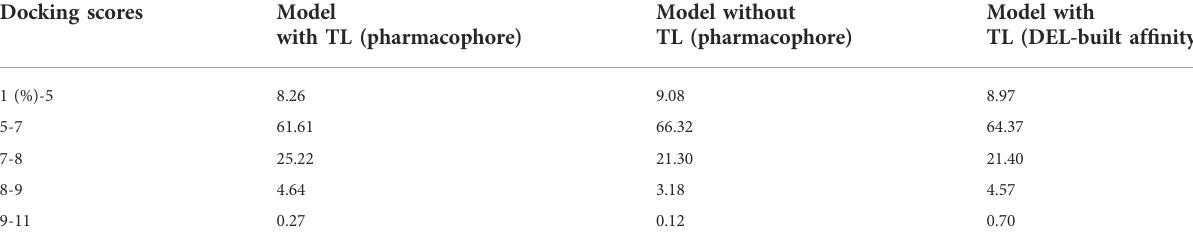
Model without TL (pharmacophore)